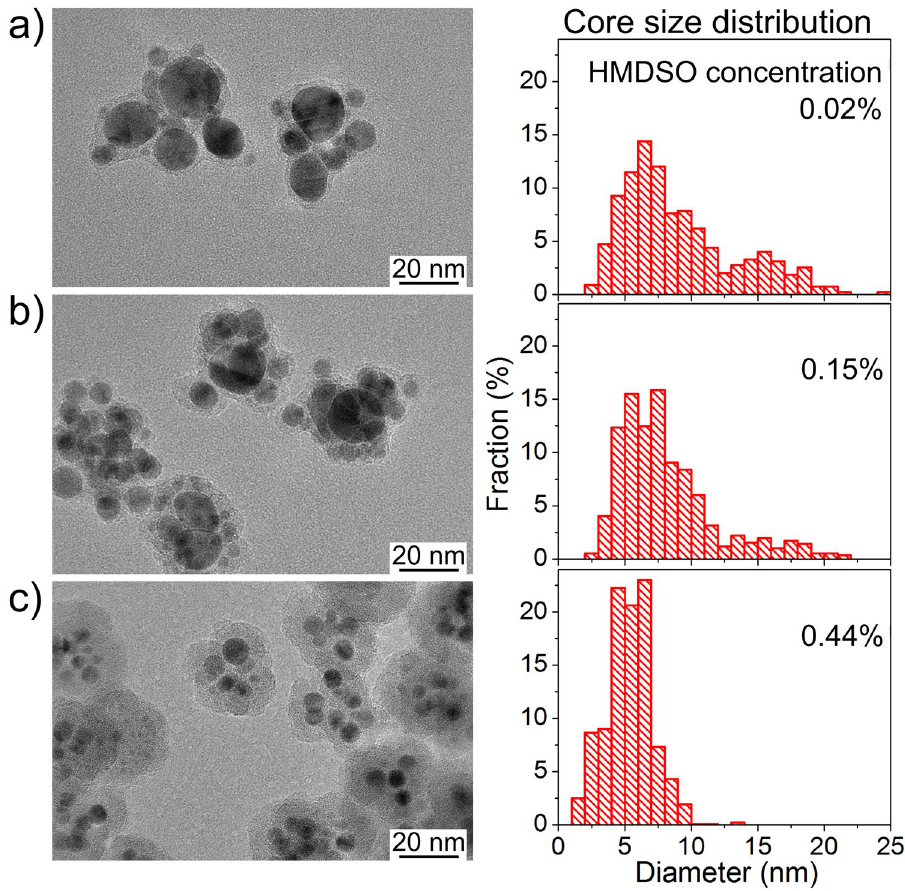
Figure 4. TEM images and the core size distributions of the multicore-shell NPs prepared by GAS at different concentrations of HMDSO: ( a ) 0.02%, ( b ) 0.15%, ( c )